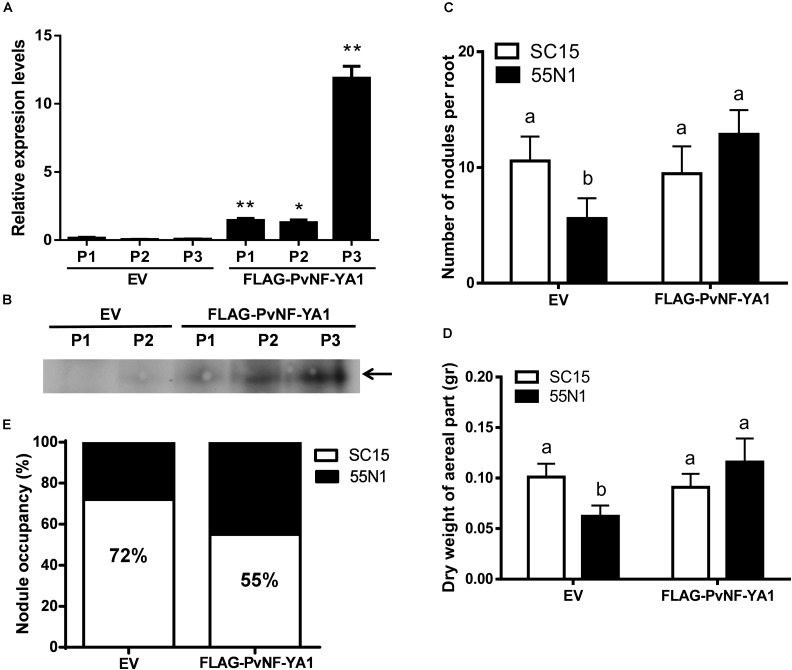
Overexpression of PvNF-YA1 enhances nodulation of the less efficient R. etli strain 55N1 and alters nodule occupancy in P. vulgaris.
(A)
PvNF-YA1 mRNA levels measured by RT-qPCR in control plants [empty vector (EV)] or independent roots of FLAG-PvNF-YA1. Error bars represent the SD of two technical replicates. Expression data were normalized to PveEF1α and presented as relative to EV. P1, P2, and P3 indicate the plant number. Asterisks indicate statistical significant differences in a t-test with P < 0.05. (B) Western blot analysis with α-FLAG antibody on root extracts from EV and FLAG-PvNF-YA1 plants. The band observed in the last three lines corresponds to the FLAG-PvNF-YA1 fusion of 38 kDa (arrow). P1, P2, and P3 correspond to the pool of transgenic roots of three different plants. (C) Number of nodules per root developed in control roots (EV) or FLAG-PvNF-YA1 at 10 dpi with strains of R. etli SC15 (white bars) or 55N1 (black bars). The error bars represent the SEM of the number of nodules formed per root present in more than 50 independent transgenic roots. Different letters indicate significantly different values in a t-test with p < 0.05. Data are the average of three independent biological experiments. (D) Dry weight of the aerial tissue of EV or FLAG-PvNF-YA1 composite plants at 21 dpi with strains of R. etli SC15 or 55N1. Error bars represent the SEM of at least 20 independent plants. Different letters indicate significantly different values in a t-test with p < 0.05. Data are the average of three independent biological experiments. (E) Percentage of nodule occupancy by strains SC15 (white) and 55N1 (black) in co-inoculation experiments. Nodule occupancy was determined at 21 dpi by examination of nodC polymorphic profiles of bacteria isolated from more than 100 individual nodules collected from a minimum of 10 co-inoculated plants for each construction. The results are the average of three independent biological experiments.